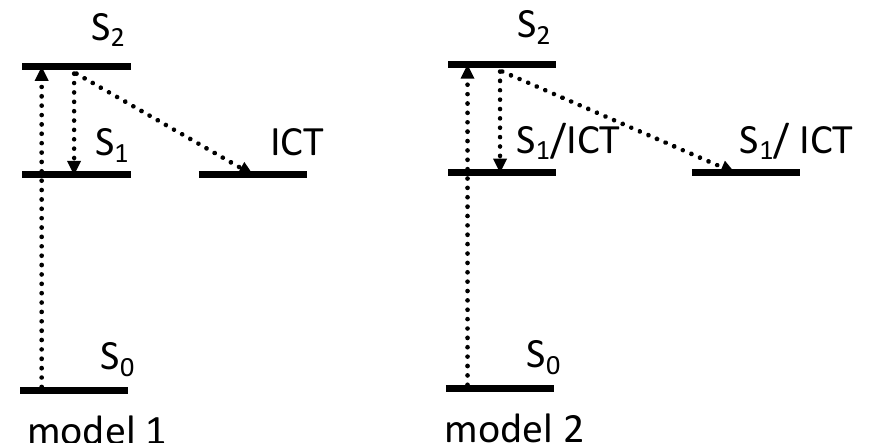
Figure 8. Two schematic models of the excited state dynamics of carotenoid in OCP. The first model assigns the multiexponential character of the S1 excited state in OCP to the different contribution of ICT in excited state kinetics [49–51], while model two shows OCP population heterogeneity [50,52,53]. The origin and contribution of S* to OCP photocycle is discussed in Section 6.